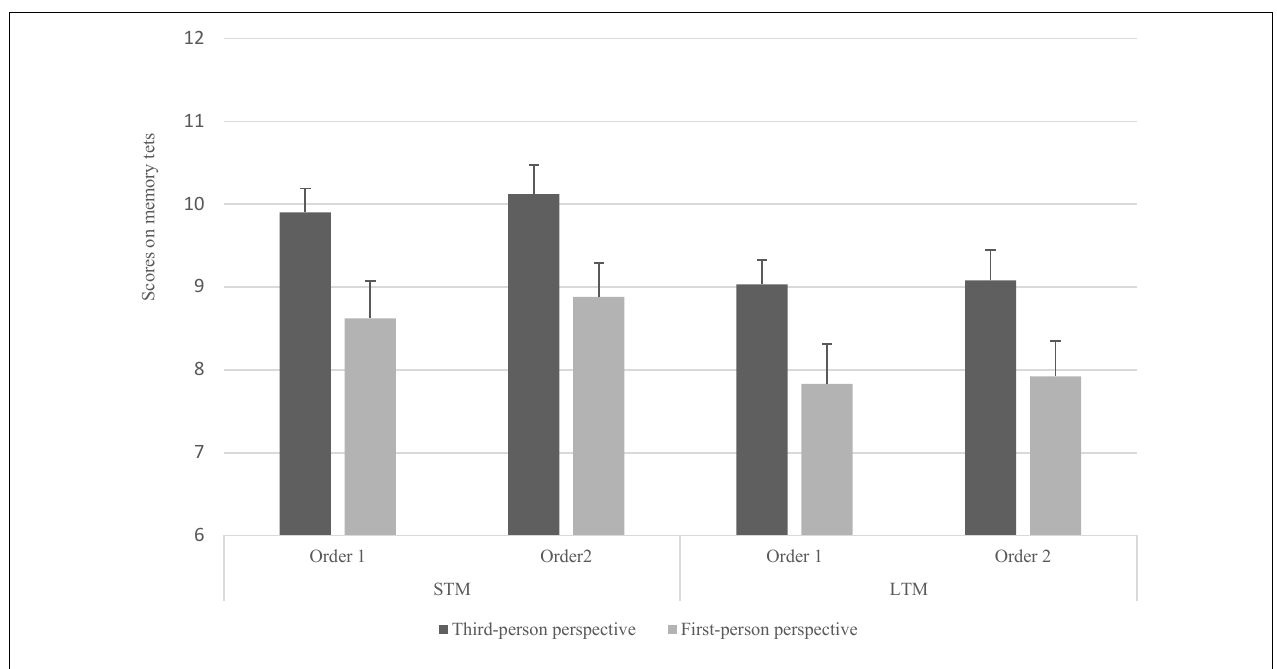
FIGURE 1 | Mean (and SE) of the performance on the memory tests by group, narrative perspective, and memory